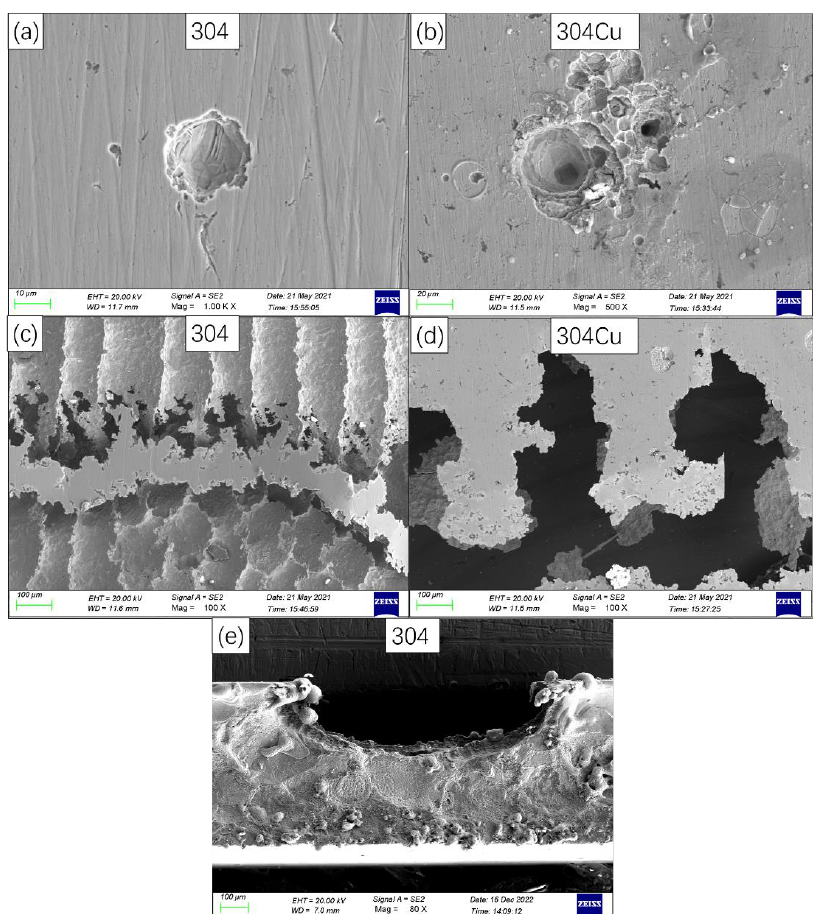
Figure 4. Morphology of ( a , b ) non-penetrating and ( c , d ) penetrating pits in 304 and 304Cu; ( e ) cross- section of 304 pits after 72 h FeCl 3 immersion tests.